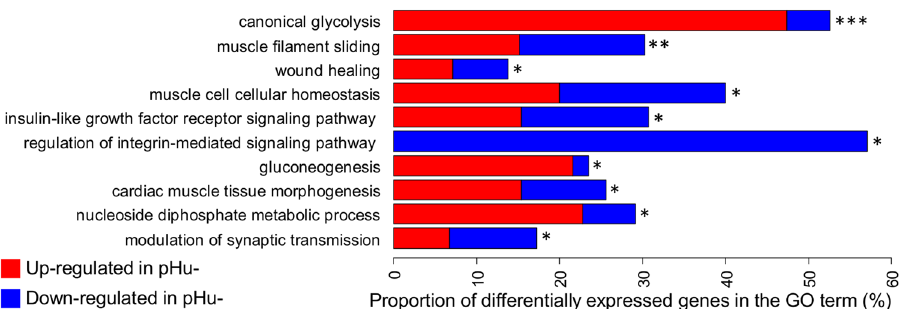
Figure 3. Top 10 enriched biological process GO terms. A functional enrichment analysis of the biological process GO terms was performed using the topGo R package on the genes that were differentially expressed in the breast pectoralis major muscle from the two lines of broilers divergently selected for their breast meat ultimate pH. The levels of significance are indicated by *** p-value ≤ 1 × 10 − 5 , ** p-value ≤ 0.001, and * p-value ≤